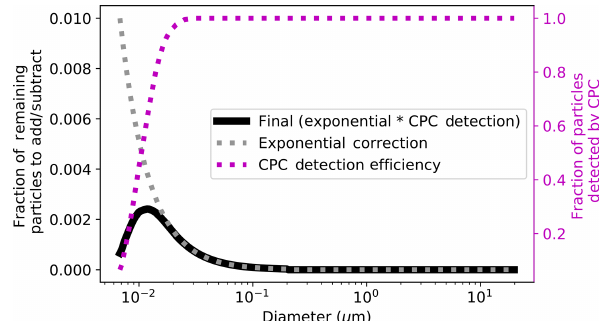
Figure A2. Fraction of particles to either add or remove from the size distribution during Step 4 of the adjustments (black), which was based on the multiplication of an exponential function (cyan) and CPC detection efficiencies (magenta, right